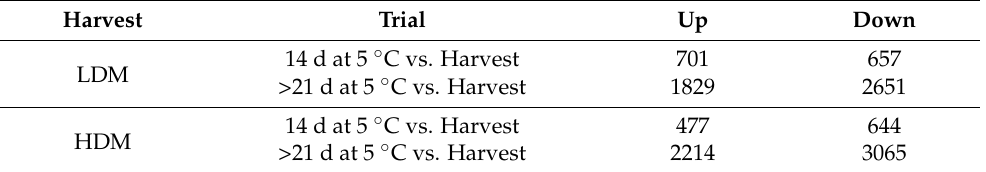
Table 1. The number of differentially expressed genes (DEGs) with different cold storage times compared with fruit at